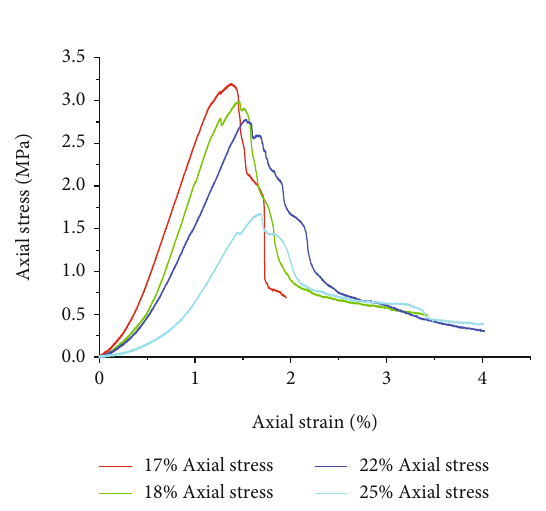
Figure 3: Complete stress-strain curves of coal samples with di ff erent moisture